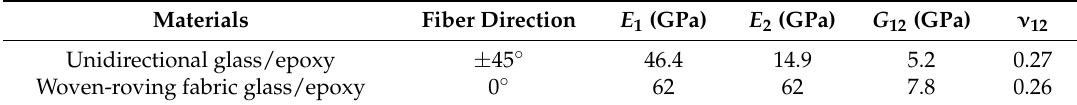
Table 2. Mechanical properties and fiber directions of the tested specimens—“0°” means the warp direction.